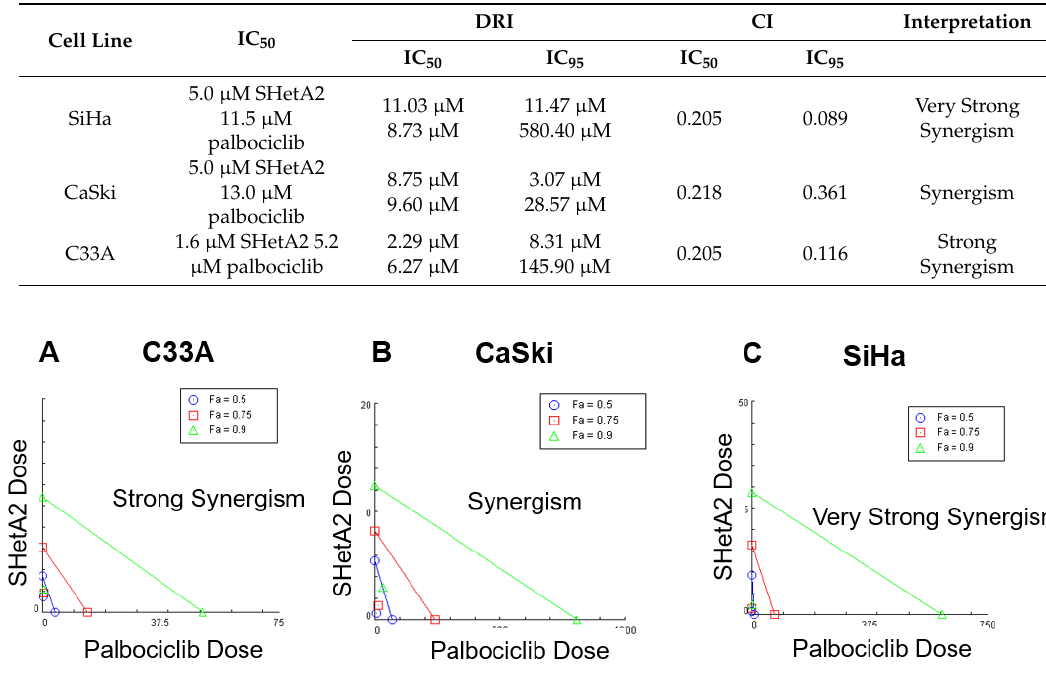
Table 1. Chou-Talalay method results of SHetA2 and palbociclib combination.